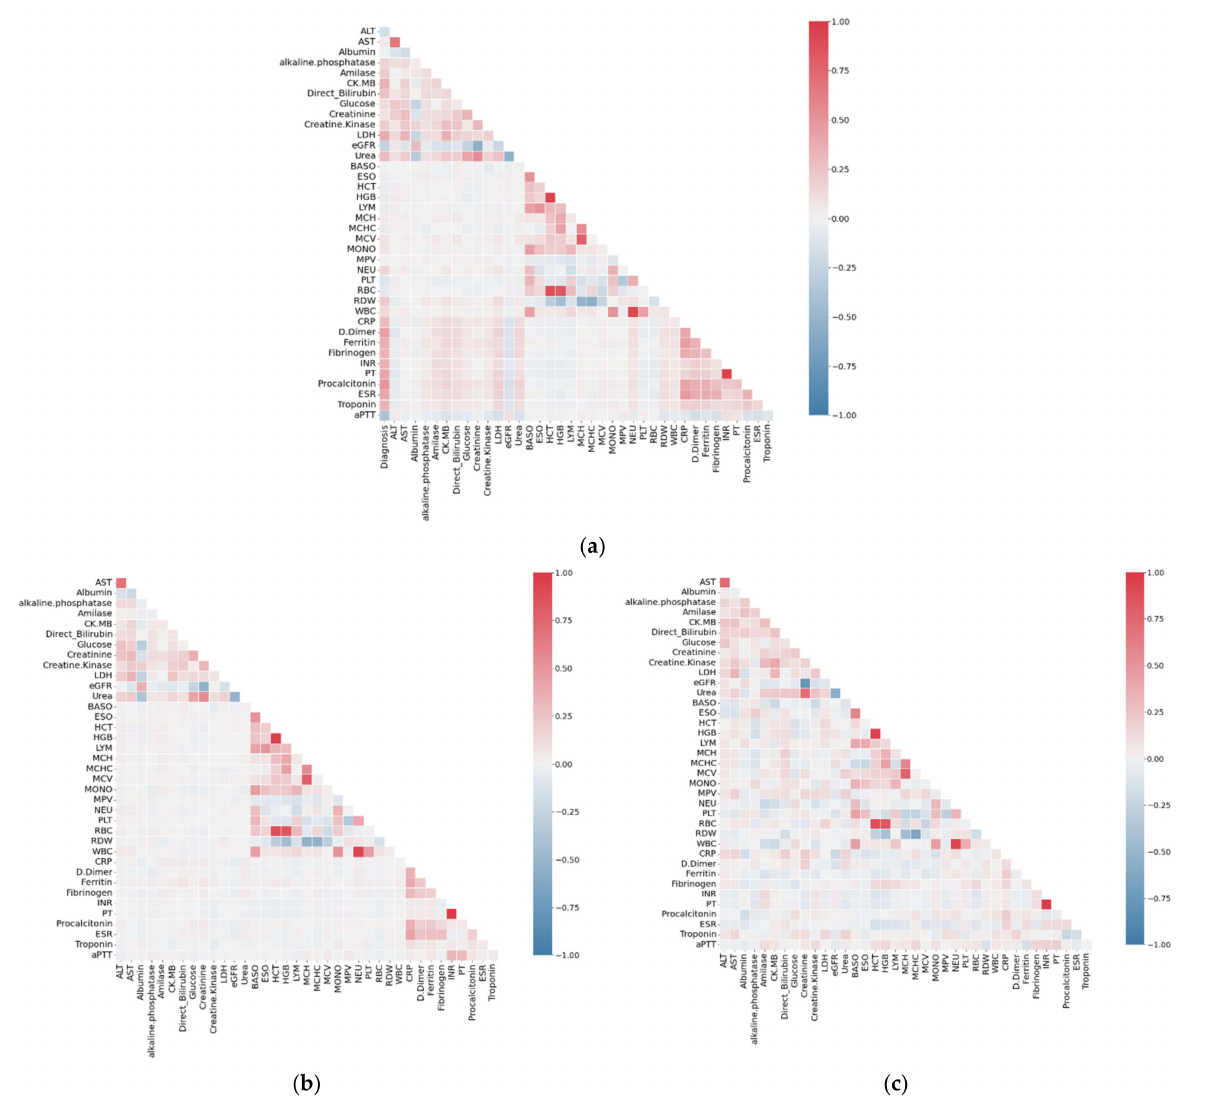
Figure 2. Spearman correlation analysis results for ( a ) the entire database, ( b ) survived COVID-19 class, and ( c ) non-survived COVID-19 class from the SARS-CoV-2-RBV3 dataset. Table 2. Changes in the correlation of feature-pairs of the non-survived COVID-19-class compared with the survived